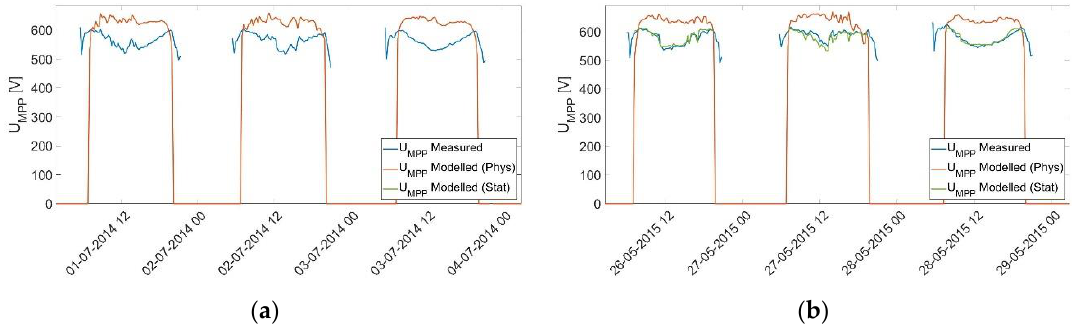
Figure 12. Voltage issue MPPT “1U08 - T2”: ( a ) initial voltage deviation; ( b ) comparison of reference values.